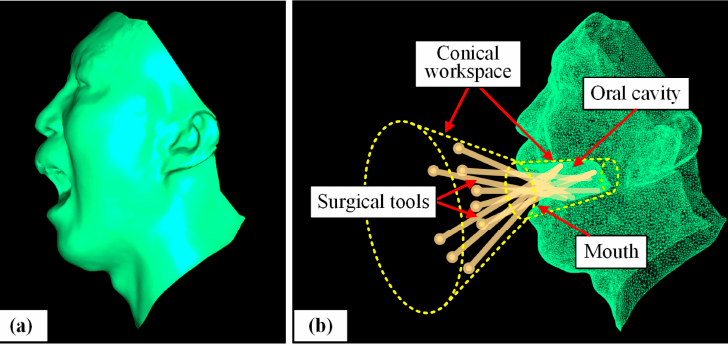
Figure 3. Geometric configuration: ( a ) A scanned model; ( b ) Conical workspace of the tool.